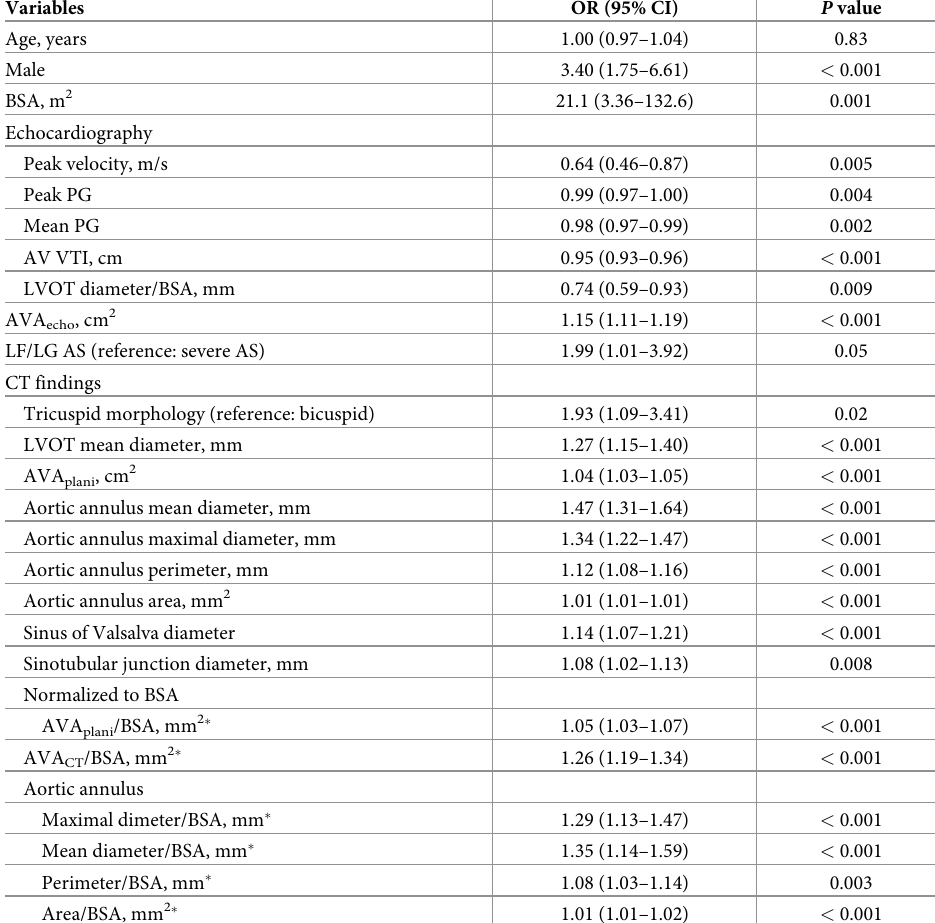
Table 4. Univariate logistic regression analysis of clinical and CT characteristics to predict the discordance between the aortic valvular areas measured by echocardiography and CT.